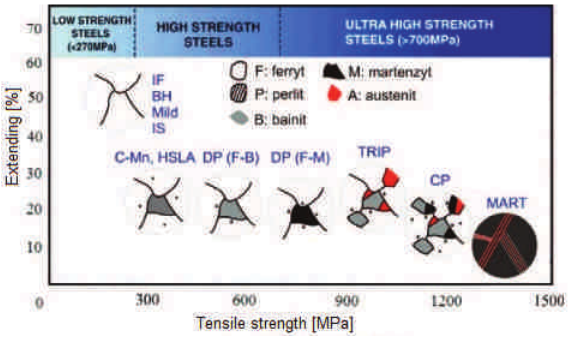
Fig. 4. Schematic presentation of the microstructure of different types of conventional and multiphase steels in transport